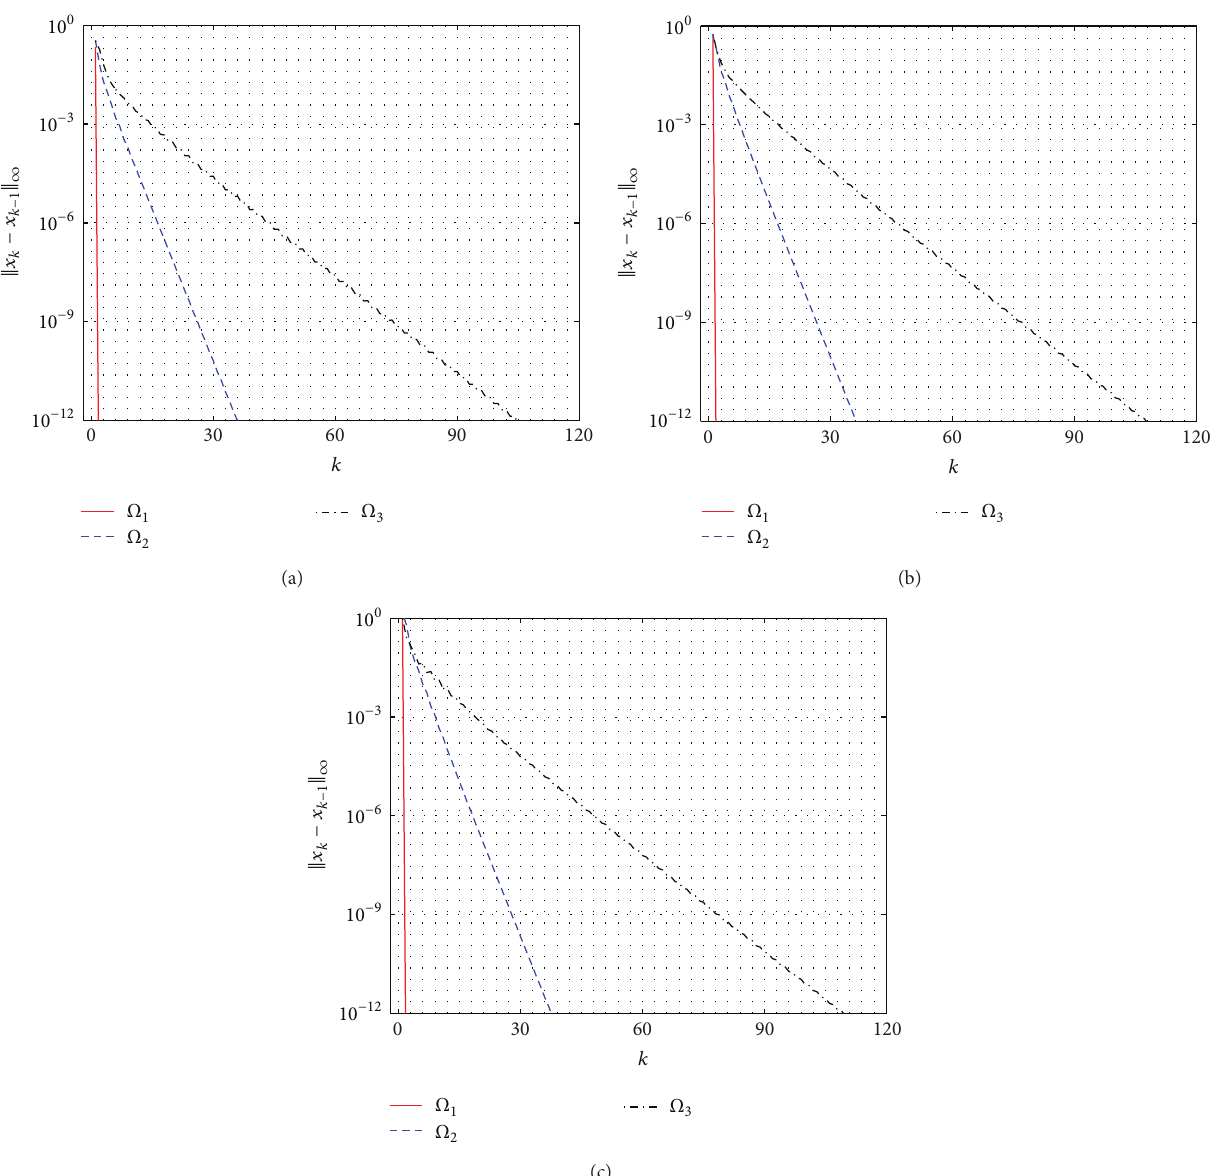
Figure 4: The error norm ‖ x 𝑘 − x 𝑘−1 ‖ ∞ versus the iteration number 𝑘 for (a) the conformal mapping from 𝐺 1 onto Ω 1 , Ω 2 , and Ω 3 , (b) the conformal mapping from 𝐺 2 onto Ω 1 , Ω 2 , and Ω 3 , and (c) the conformal mapping from 𝐺 3 onto Ω 1 , Ω 2 , and Ω 3